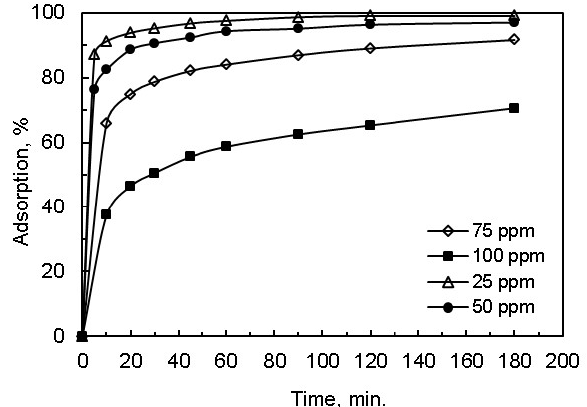
Fig. 6. Effect of initial concentration on dye adsorption for various contact